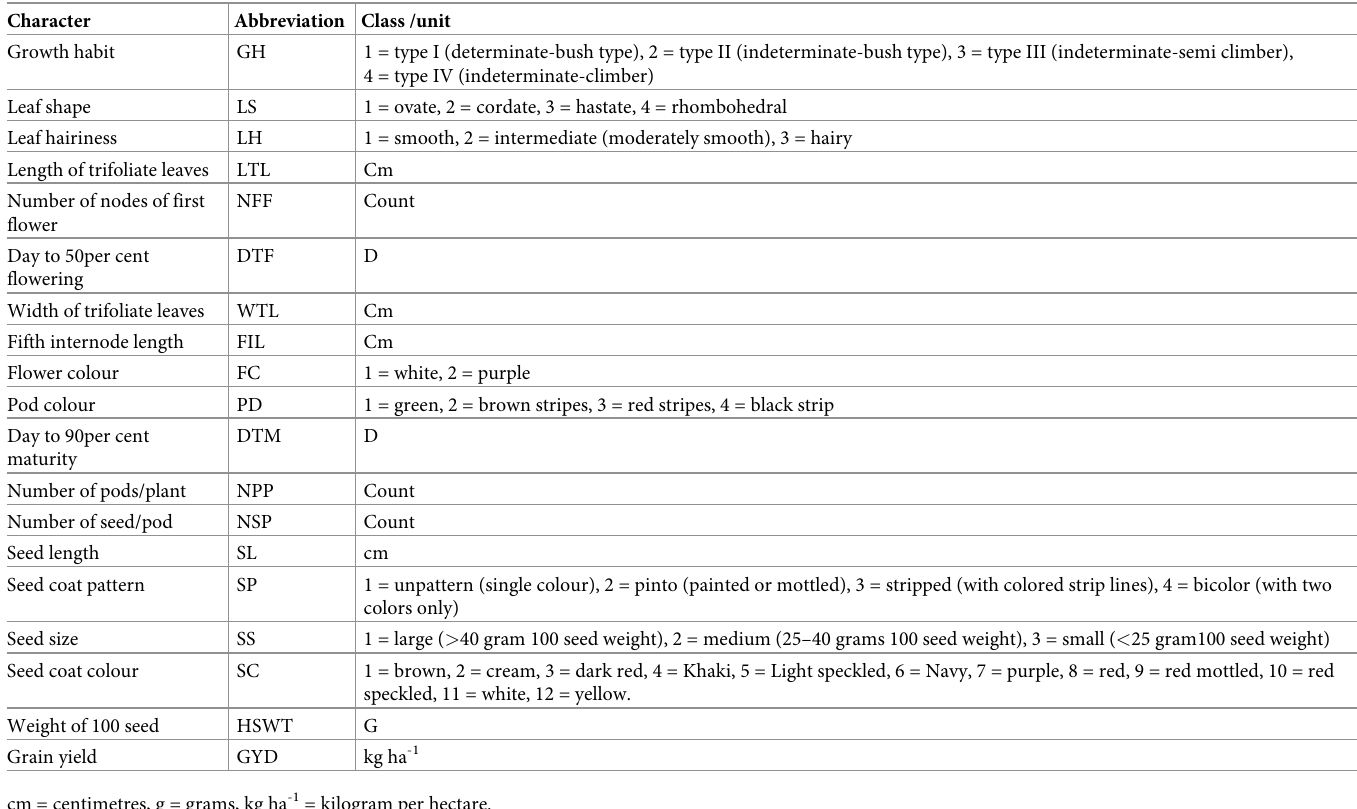
Table 2. Agro-morphological traits used to characterise the common bean genotypes in the